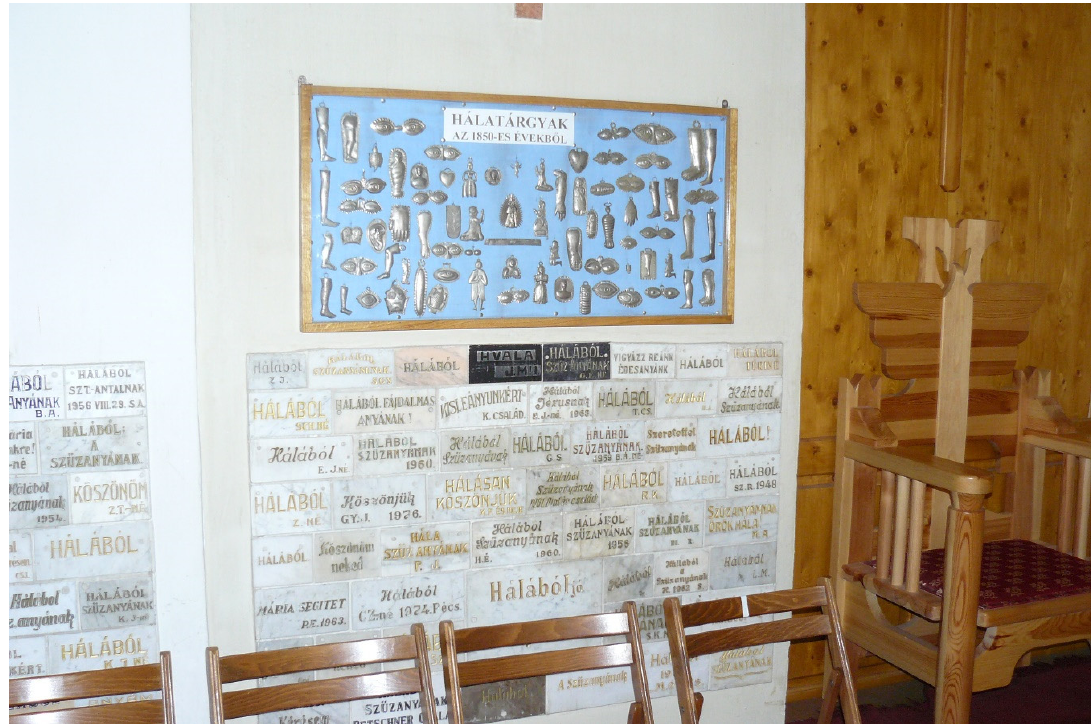
Figure 9. Gratitude tablets in Máriagy ű d, Photo taken by Krisztina Frauhammer, 2008.